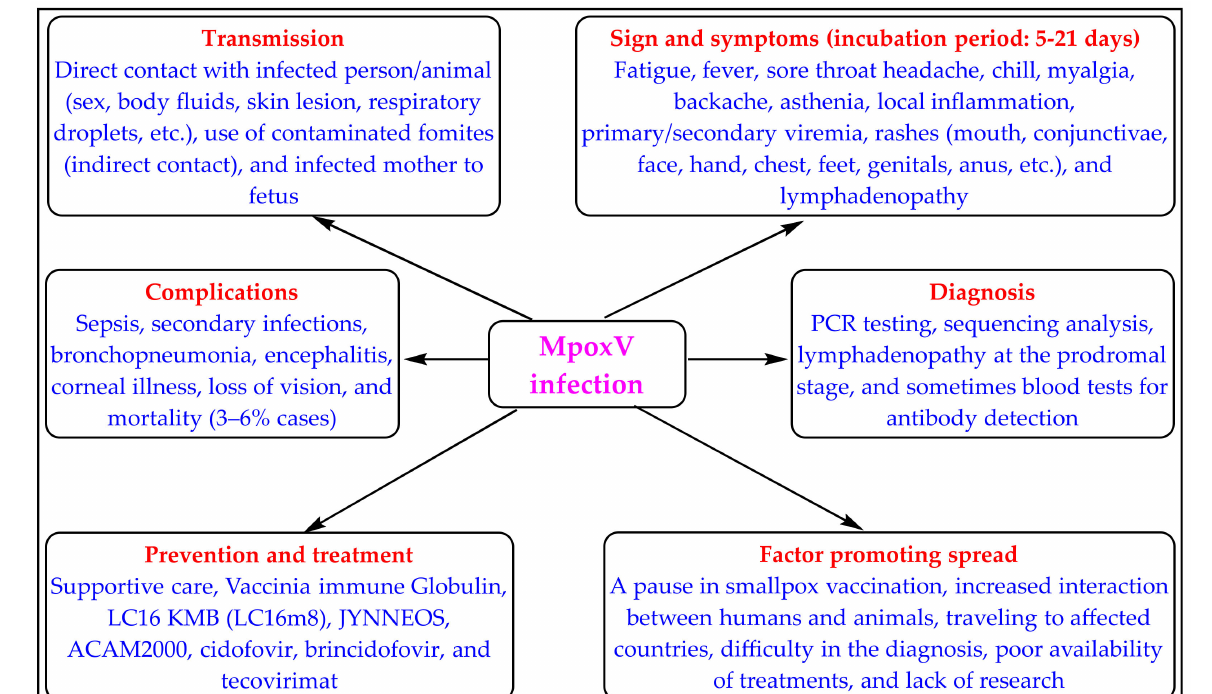
Figure 1. Mode of transmission, symptoms, diagnosis, complications, prevention, and treatments of Mpox.